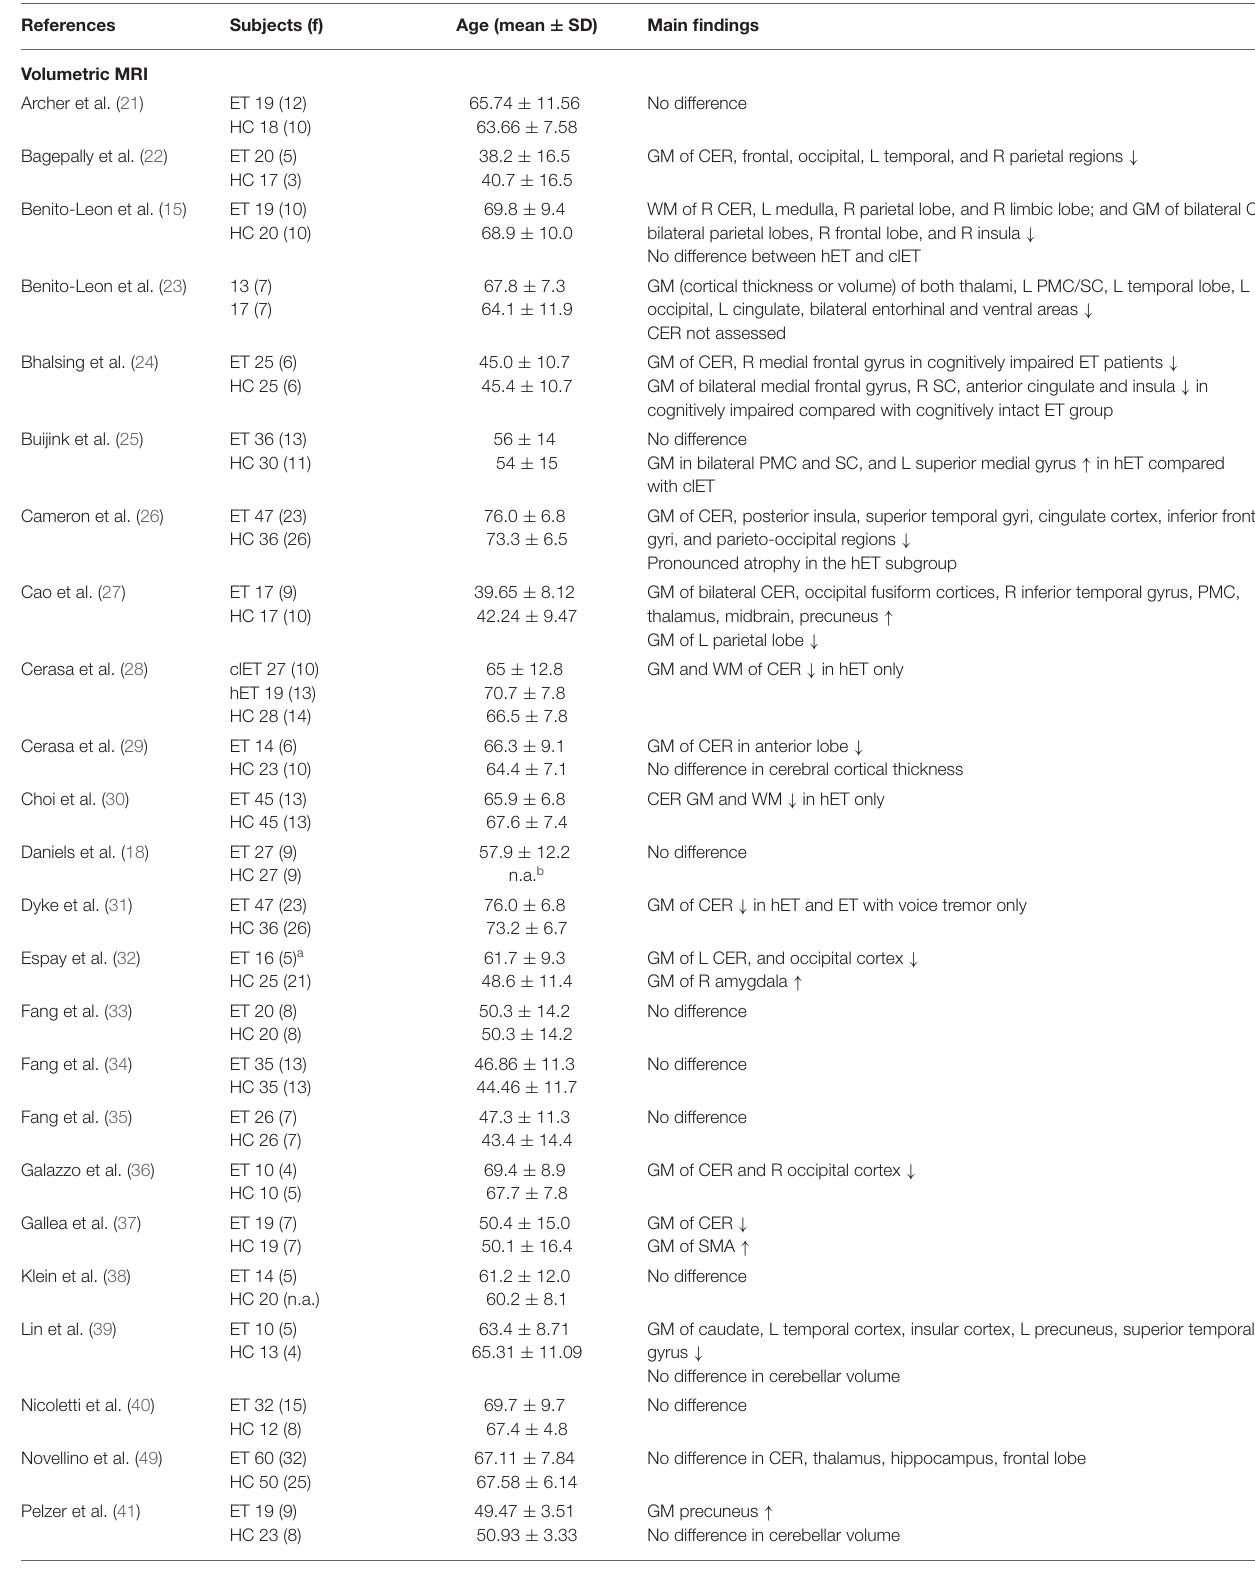
TABLE 1 | Summary of MRI and GABAergic imaging